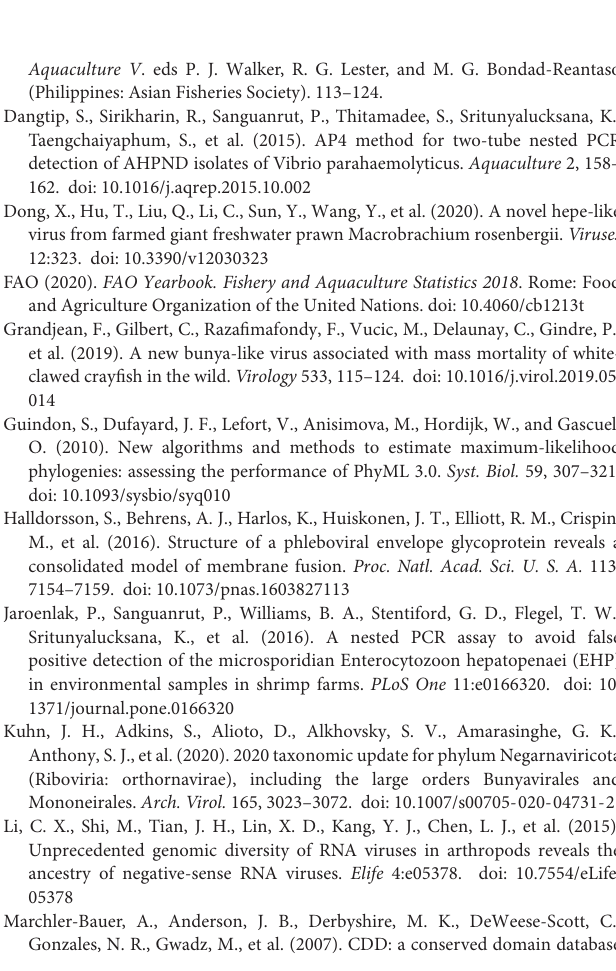
Supplementary Figure 1 | Phylogenetic analysis of glycoprotein sequences of oriental wenrivirus 1 (OWV1) and representative viruses in the family Phenuiviridae . OWV1 is highlighted in red and with a red star. Supplementary Figure 2 | Phylogenetic analysis of nucleoprotein sequences of oriental wenrivirus 1 (OWV1) and representative viruses in the family Phenuiviridae . OWV1 is highlighted in red and with a red star. Supplementary Table 1 | Virus-host relationship of Phenuiviridae